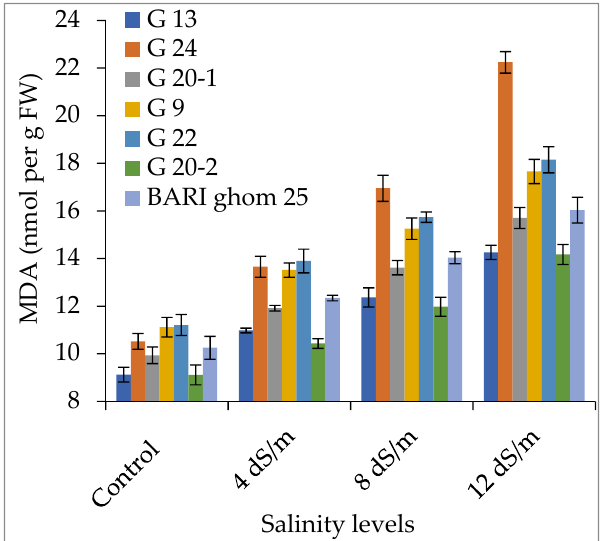
Figure 19. Melondealdehyde (MDA) accumulation in leaf of wheat genotypes under various salinity levels. The vertical bar indicates average data five independent replicates ( n = 5). Error bars represent standard error.